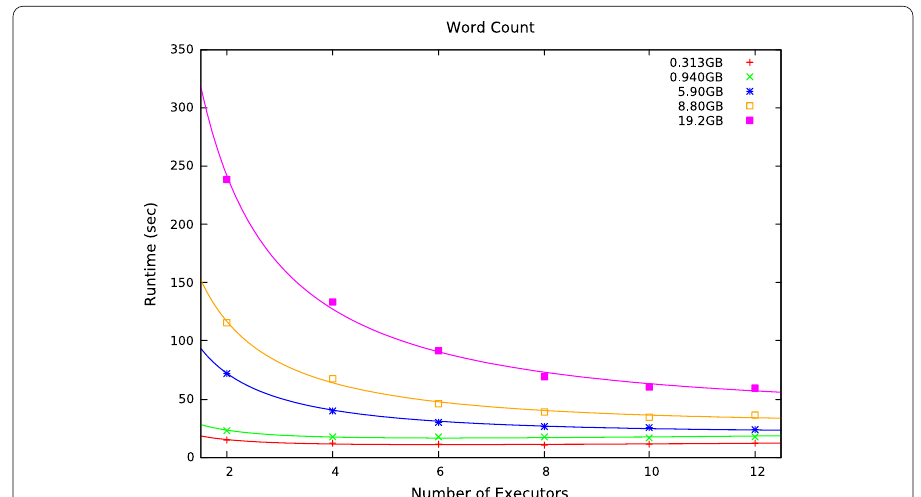
Fig. 14 Fitting the 2D plate model to